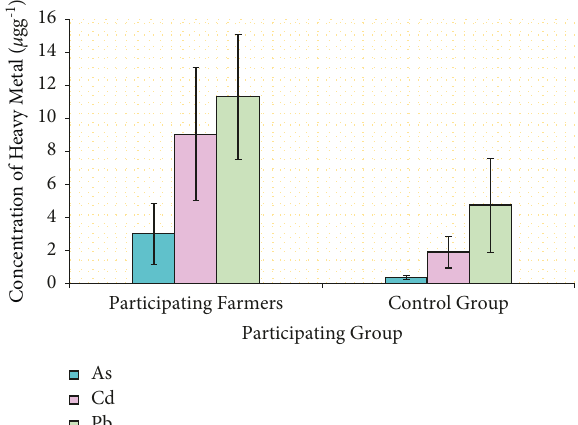
Figure 1: Concentration levels of heavy metals in fingernail samples of the participating farmers and the control